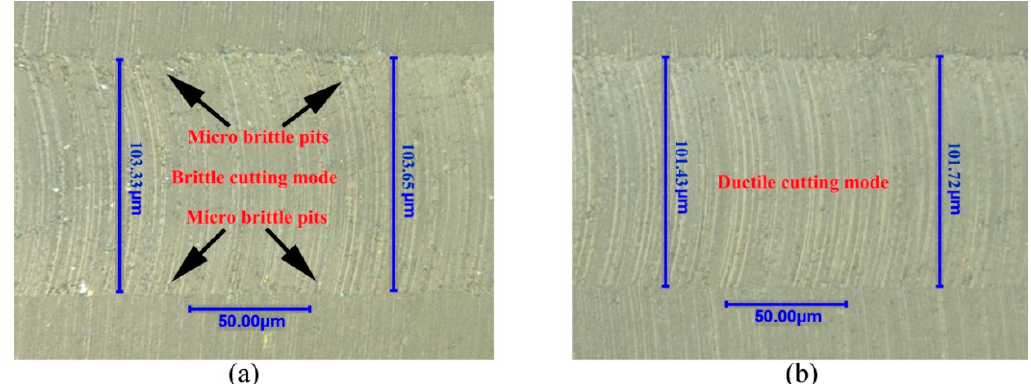
Figure 9. The morphology of machined grooves under the depth of cut of 5 μ m with the spindle speed of: ( a ) 10,000 r/min, ( b ) 40,000 r/min.